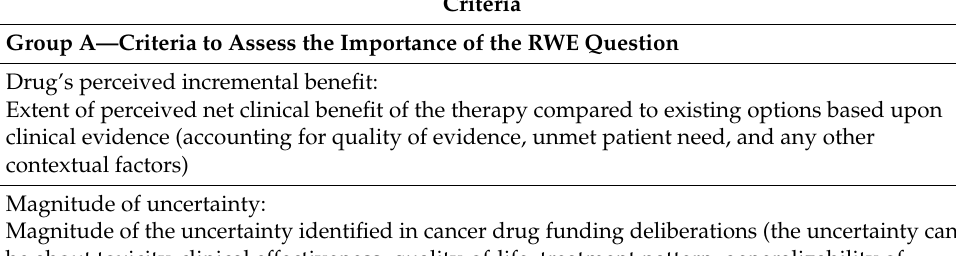
Table 1. Updated MCDA Rating Tool Criteria.